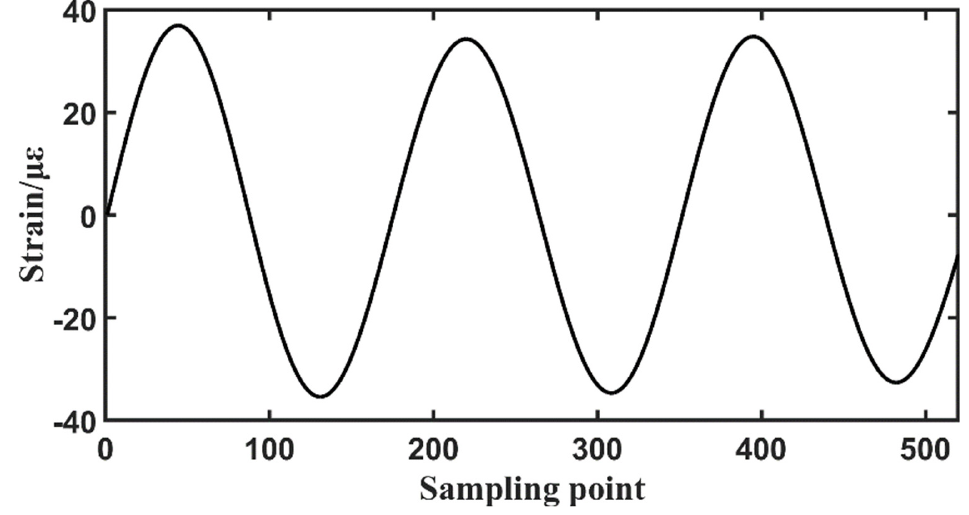
Figure 12. Filtered time-domain signal.